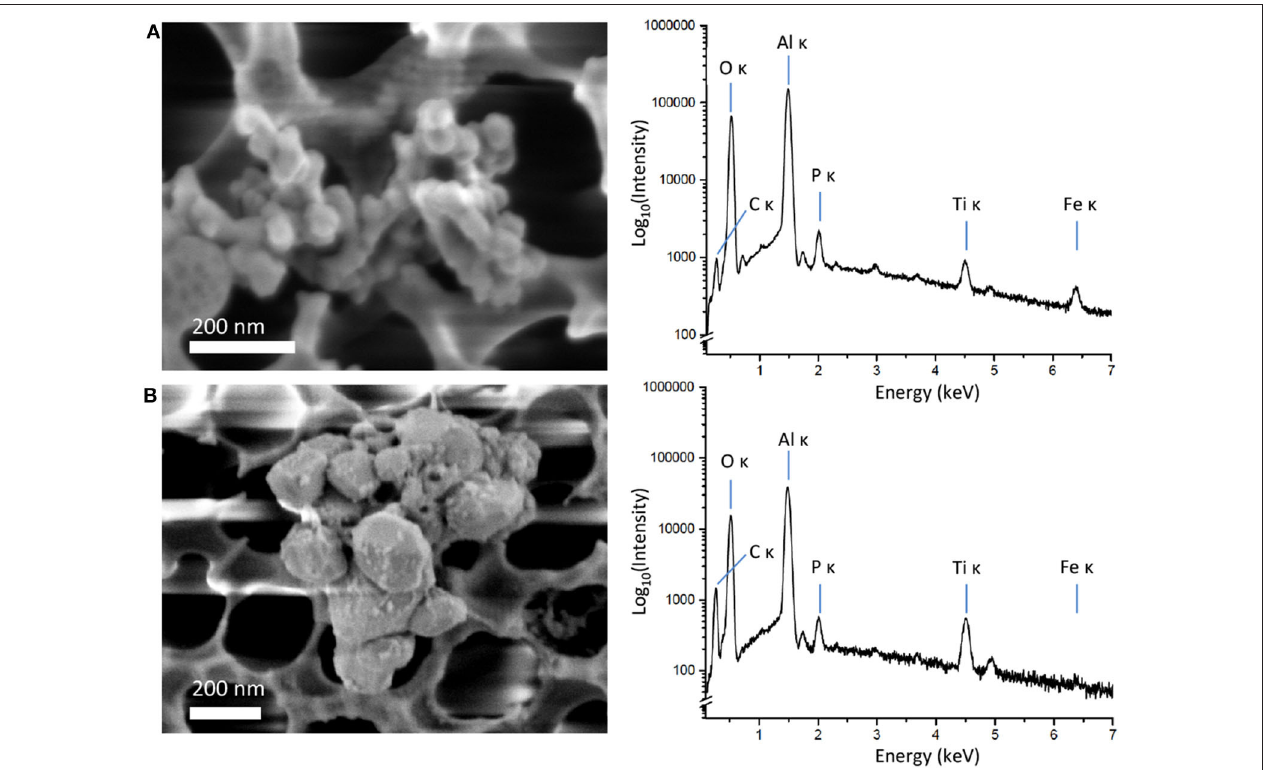
FIGURE 6 | SEM images (left) and corresponding EDS spectra (right) of particles recovered on 0.20 µ m filters from (A) Industrial Effluent and (B) WWTP in October 2017. Some charging features present in SEM images as a result of no coating being applied to